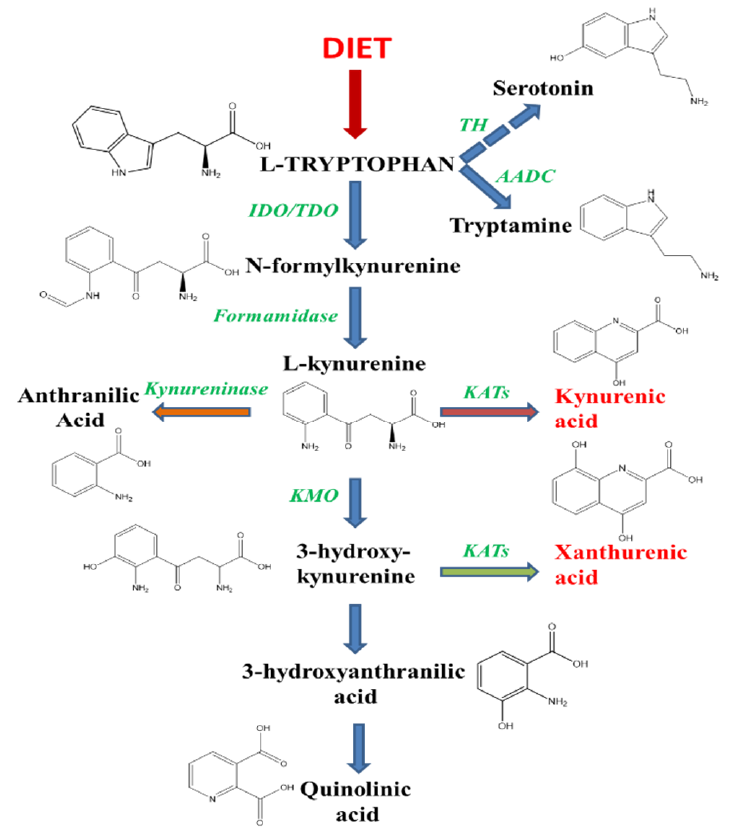
Figure 1. Tryptophan as a precursor of serotonin, XA and tryptamine. Tryptophan is an essential amino acid the concentration of which is regulated by food intake and gut microbiota. Tryptophan and many of its metabolites are transported into the brain via regulated mechanisms and give rise to many active compounds in the CNS. The principal pathway is degradation through kynurenine and the synthesis of two related analogues, kynurenic and xanthurenic acid. These two compounds have opposite effects on dopamine disposal in the brain. In addition, tryptophan is the precursor of the serotonin neurotransmission pathway and of tryptamine, an indolamine compound which stimulate trace-amine receptors in the CNS, especially TAAR1. The three pathways of tryptophan degradation produce substances linked to psychosis and are involved in the modulation of dopamin- ergic activities in the brain. TH, tryptophan hydroxylase; AADC, aromatic amino-acid decarboxylase; IDO, indolamine dioxygenase; TDO, tryptophan dioxygenase; KATs, kynurenine aminotransferases; KMO, kynurenine